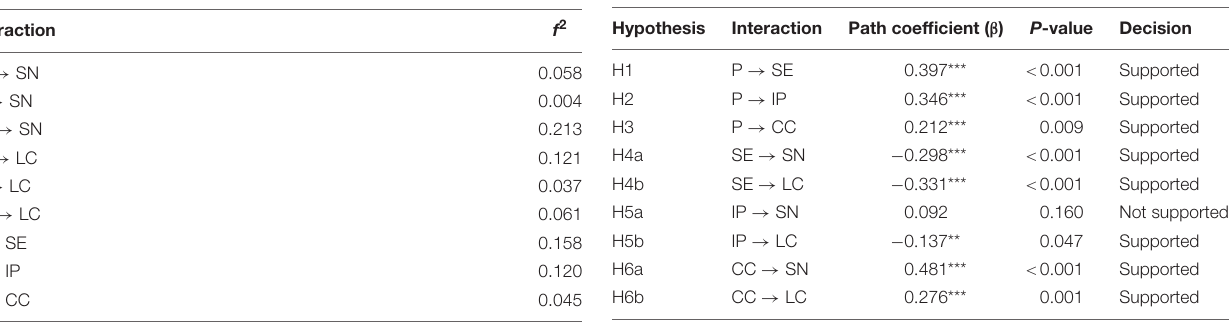
TABLE 5 | Effect size ( f 2 ). TABLE 6 | Path coefficients and P